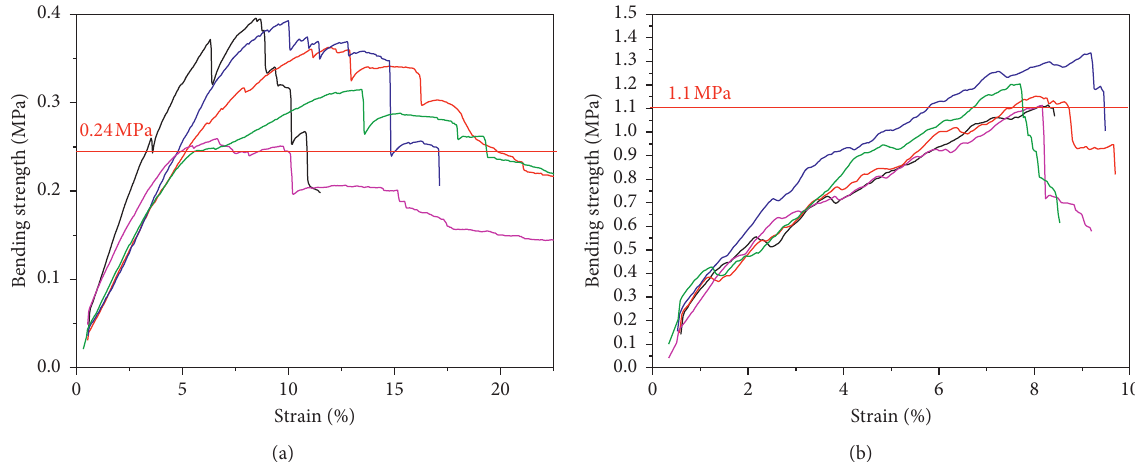
Figure 16: Bending strength diagrams of carbon/carbon fiber composites: (a) front bending ( Z direction); (b) side bending ( X direction or Y